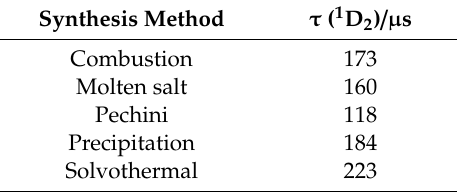
Table 7. 1 D 2 → 3 H 4 Pr 3 + average lifetimes of Y 2 O 3 : Pr 3 + NCs after optimization of the di ff erent